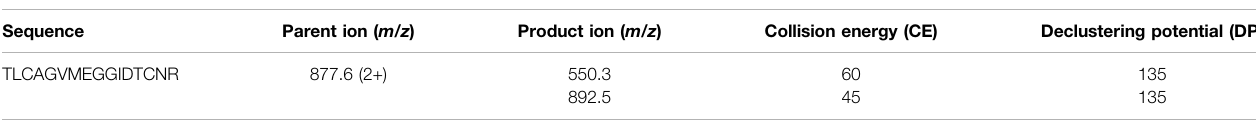
TABLE 1 | MRM transitions for the marker peptide of Agkistrodon halys pallas.